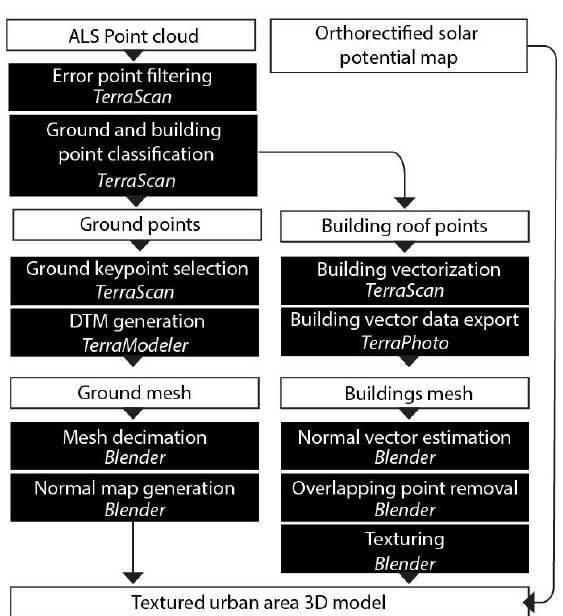
Figure 2. (a) The original high detail DTM, (b) A decimated version, (c) A false color normal map depicting surface normal differences between the detailed and simple version, allowing the simple version to be rendered with more detail. The lower row shows close-ups from the area marked in red for illustration.